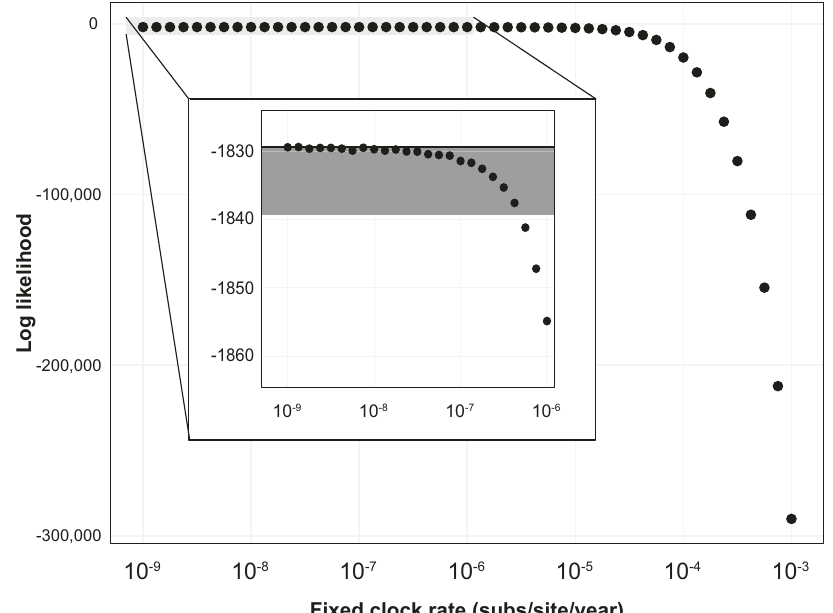
Fig. 2 | Shape oflikelihood surface for HSV-2 clock rate onempiricaldata. Log- likelihood of HSV-2 chronogram with a range of fi xed clock rates estimated using the maximum likelihood topology. The black line is best-estimated log- likelihood. The gray shaded box is the area shown in insert. Within the insert,